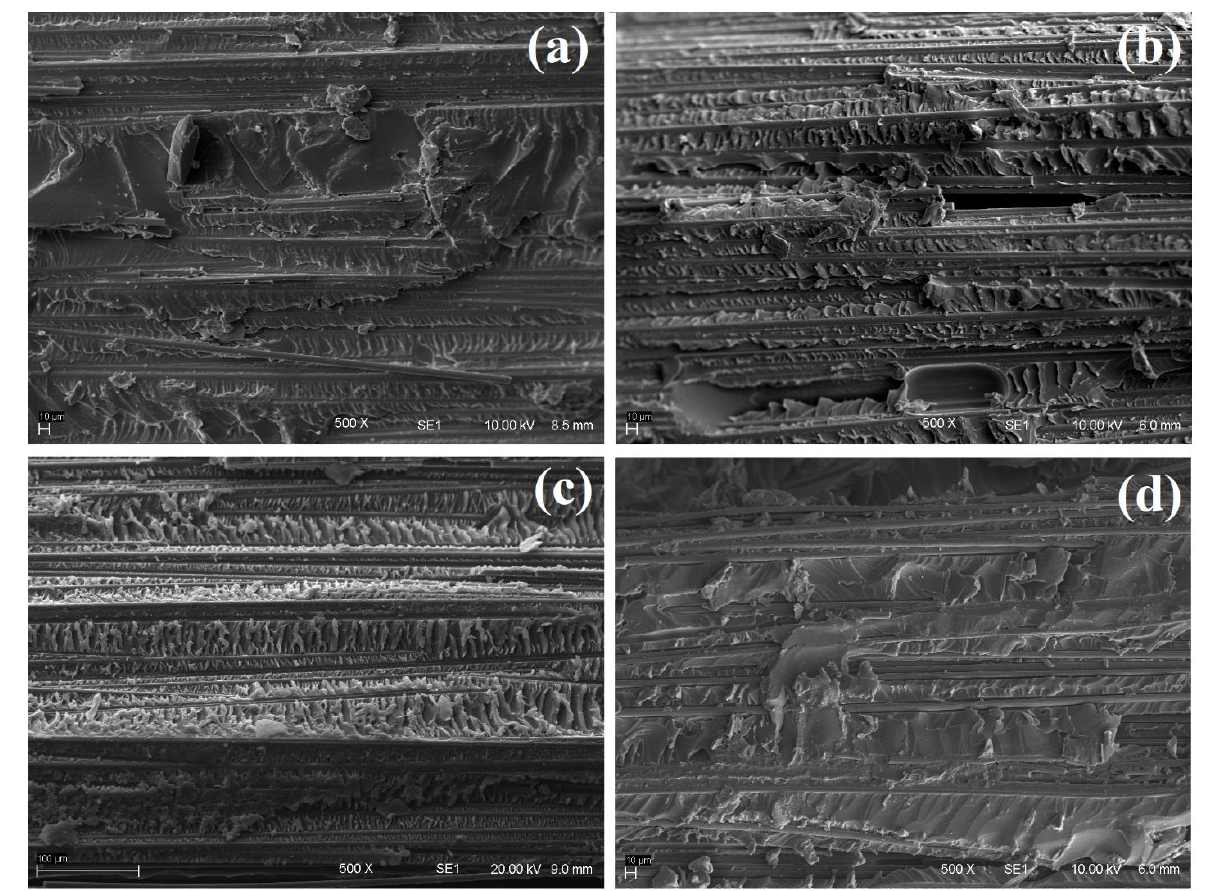
Figure 4 . SEM micrographs of the interfacial pull-out region of the samples: ( a ) CF, ( b ) CF-1Cl, ( c ) CF-1NTf 2 and ( d ) CF-1OH.